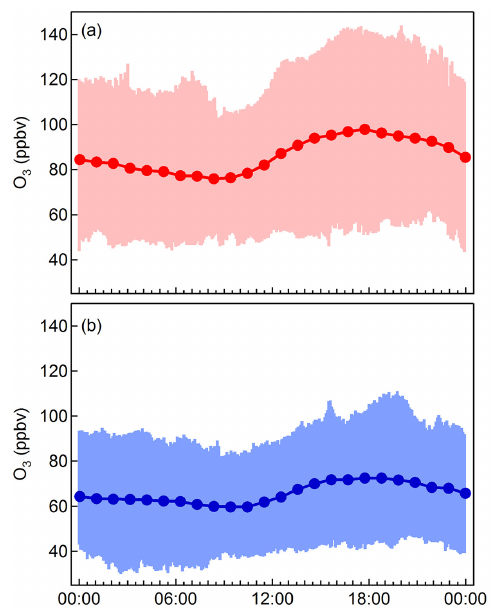
Figure 3. Average diurnal variations of surface O 3 at Mt. Tai in (a) June and (b) July-August derived from the continuous observa- tions from 2006 to 2009. The shaded area indicates the 5th and 95th percentiles of the